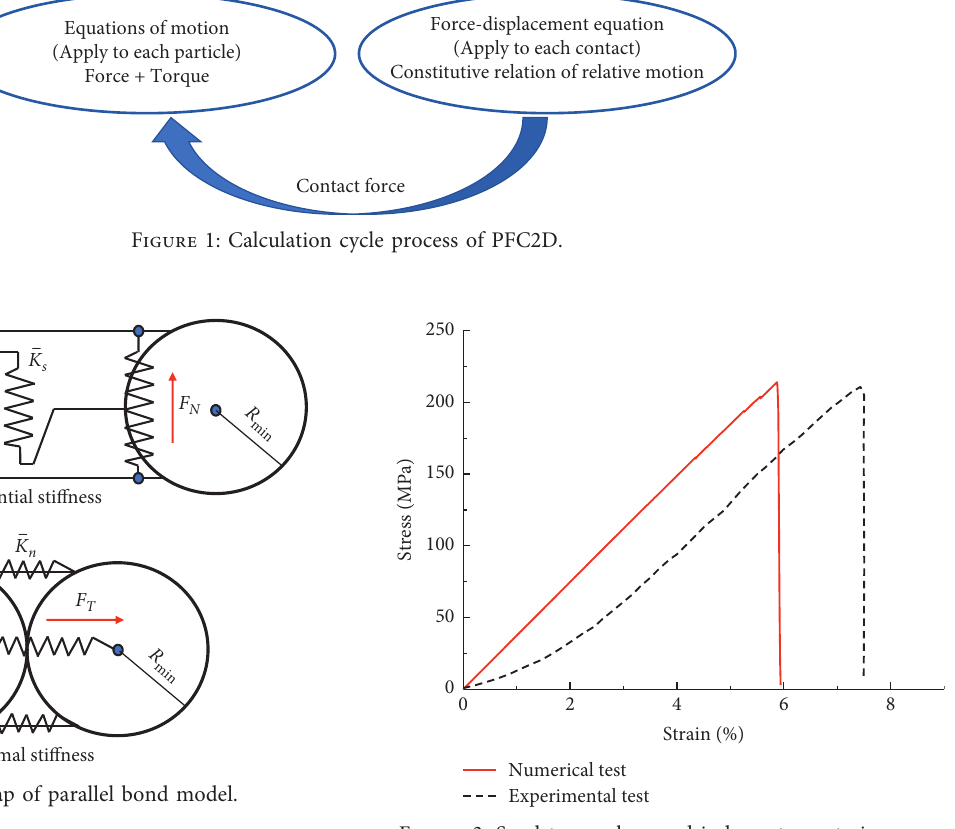
Figure 3: Sandstone values and indoor stress-strain curve.